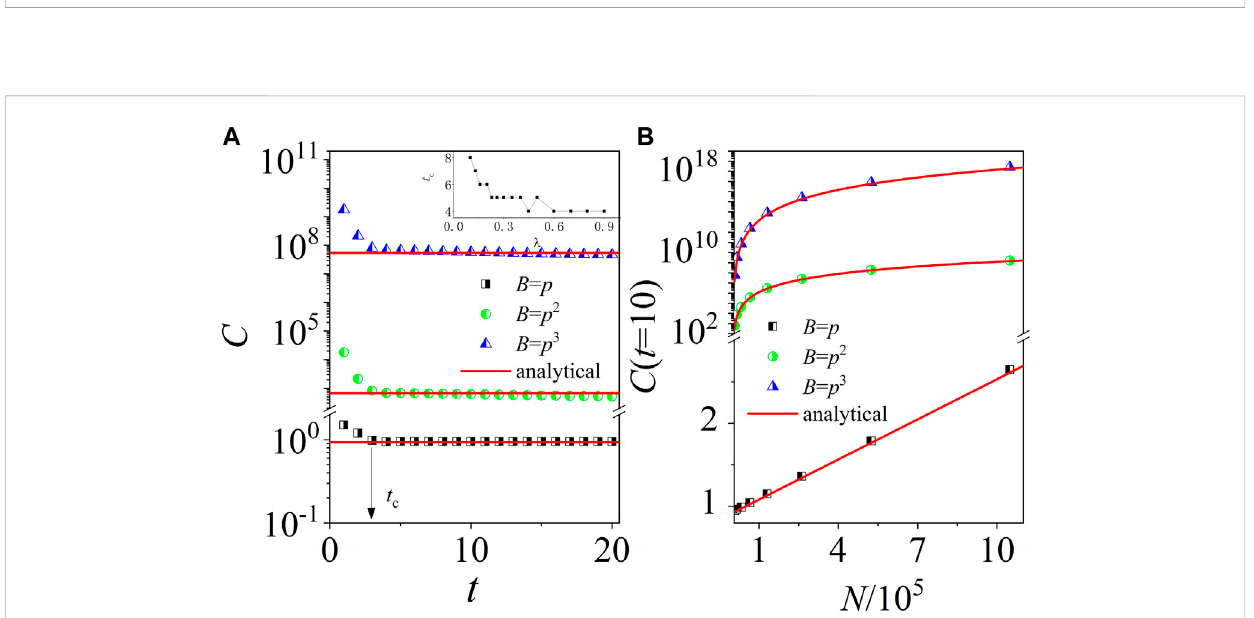
FIGURE 2 (A) Timedependenceof C ( t )with B = p (squares), p 2 (circles),and p 3 (triangles)with N =2 13 .Thearrowmarksthecriticaltime t c for B = p .Inset:Critical time t c versus λ . (B) C ( t ) at the time t = t 10 versus N . Solid lines in (A,B) denote our theoretical prediction in Eq. 4. The parameters are K = 2 π , λ = 0.9, and Z eff =